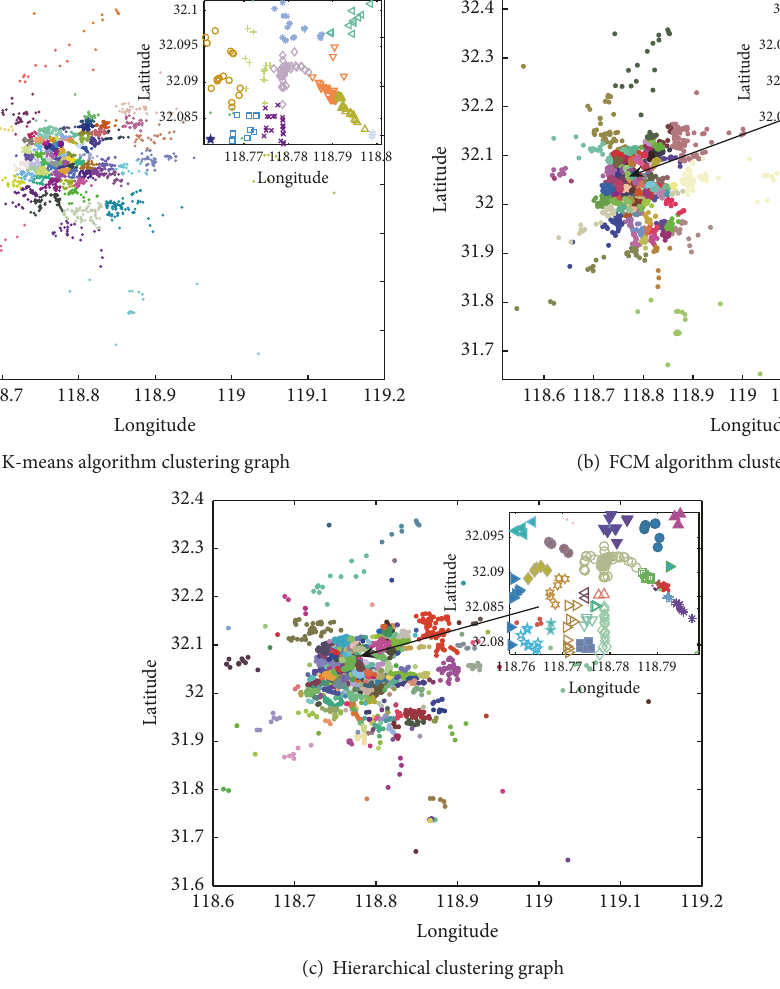
Figure 6: Classical algorithm clustering